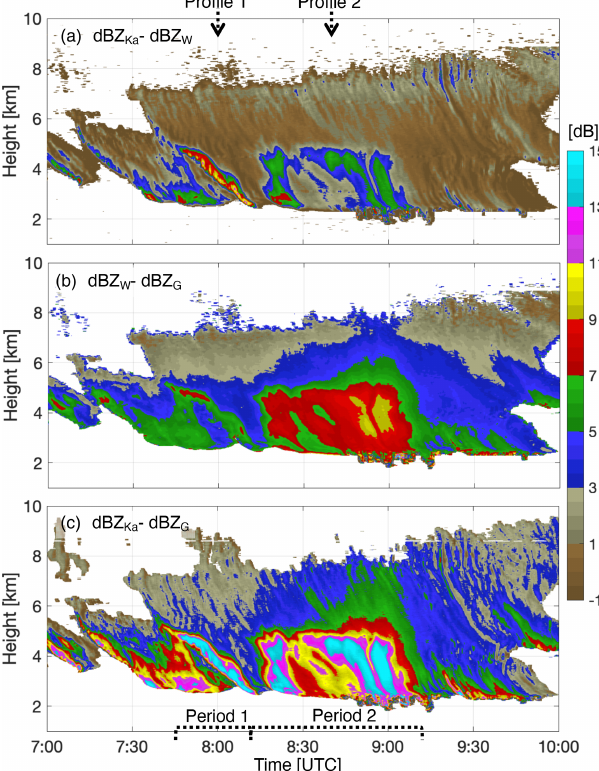
Figure 5. Time–height of dual-wavelength ratio from (a) the Ka– W pair, (b) the W–G pair and (c) the Ka–G pair estimated between 07:00 and 10:00UTC on 25 February 2020 (same date and time as in Fig. 4). The arrows in panel (a) point to the time of the profiles displayed in Fig. 6, while the periods outlined in panel (c) are the focus of Fig.